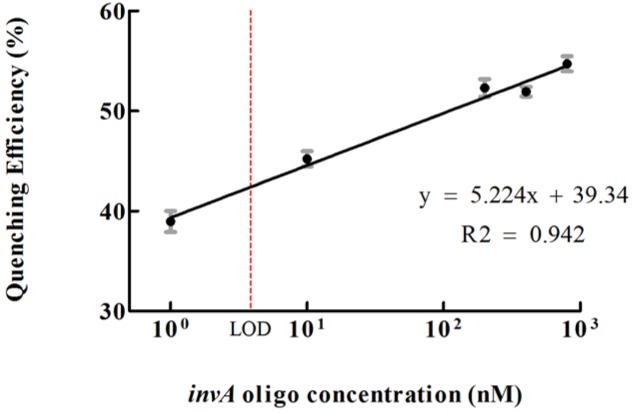
The limit of detection (LOD) of the developed invA gene biosensor. The quenching efficiencies which were calculated as according to the listed formula were potted versus different concentrations of invA oligo. LOD = 3∗S/k (S means standard deviation of negative control, k means slope).The SEM (Standard Error of the Mean) error bars were calculated from at least three replicates.